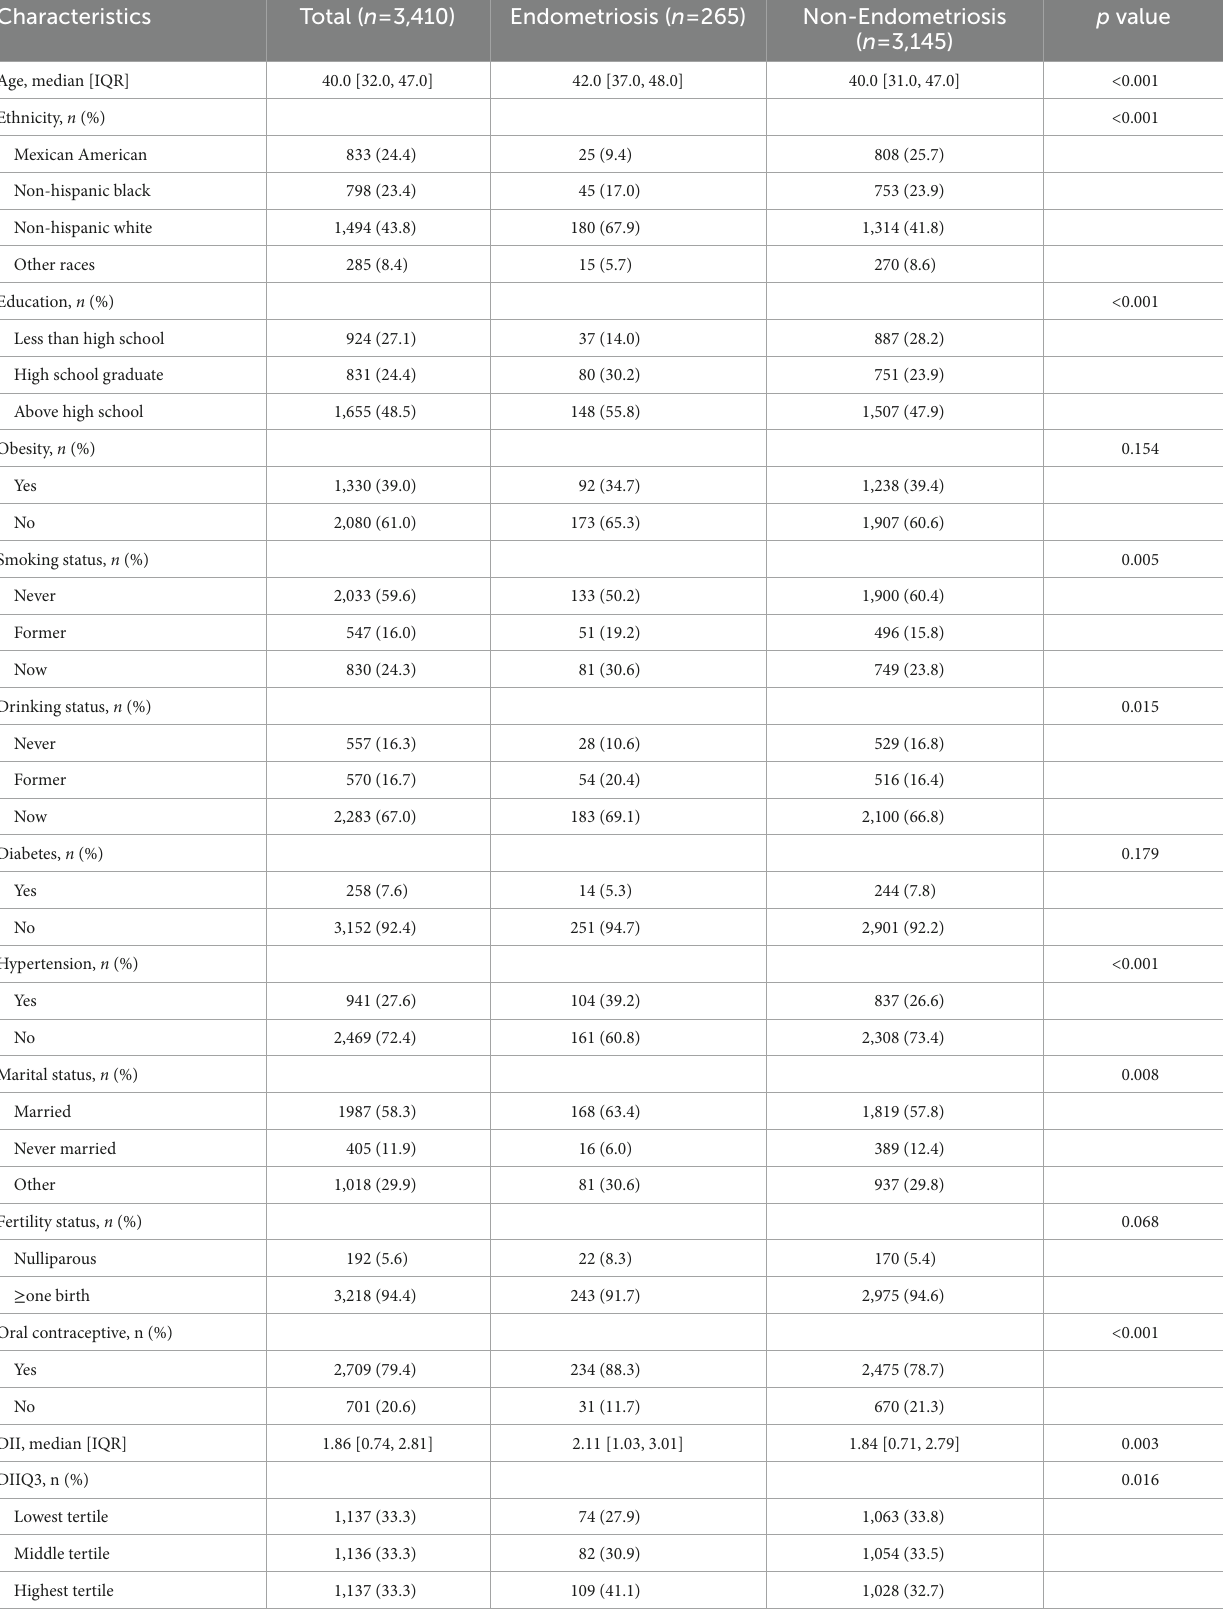
TABLE 1 Baseline characteristics distributions between endometriosis and non-endometriosis groups.